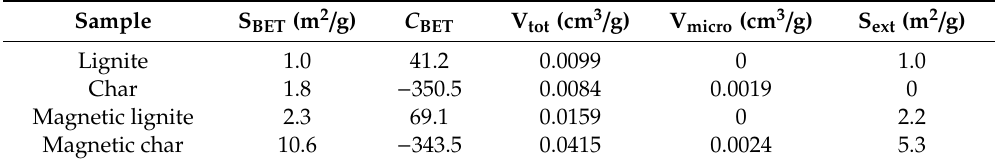
Table 2. Textural parameters for the magnetic lignite and magnetic char after high-energy ball milling. Data for the natural lignite sample and the coal char are also presented. Specific surface area (S BET ) and the C BET constant were calculated from the BET isotherm, total pore volume (V tot ) was estimated from the adsorbed gas volume at a relative pressure near 1, and the volume of micropores and the external surface (S ext ) were determined from a t-plot.